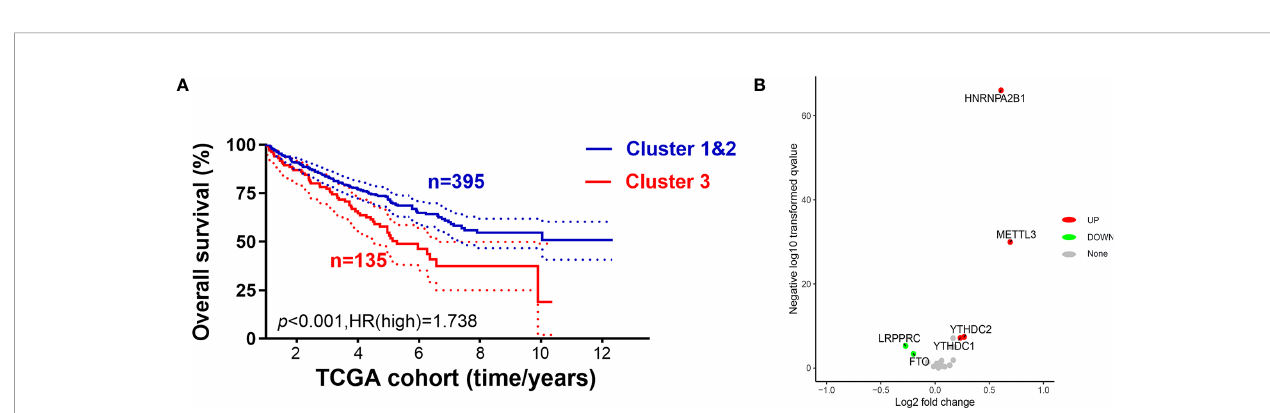
FIGURE 4 | Cluster 3 exhibited distinct clinical malignant biological phenotype and suppressive immune microenvironment than cluster 1&2. (A) We integrated cluster 1&2 and made comparisons of survival bene fi ts between m 6 AMS cluster 3 (n = 135) and cluster 1&2 (n = 395) using Kaplan – Meier method. (B) Volcano plots were constructed using fold-change values and adjusted P. The red point represents the up-regulated and the blue point indicates the down-regulated m 6 A regulators with statistical signi fi cance between cluster 3 and cluster